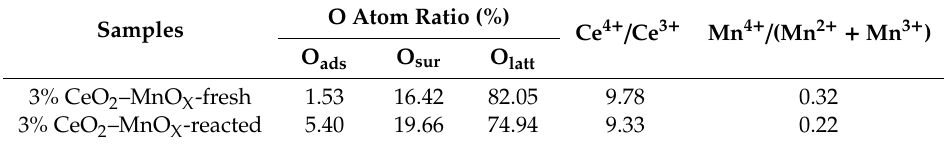
Figure 8. XPS spectra of fresh and reacted 3% CeO 2 –MnO X . Table 3. Surface atomic compositions analysis for 3% CeO 2 –MnO X .